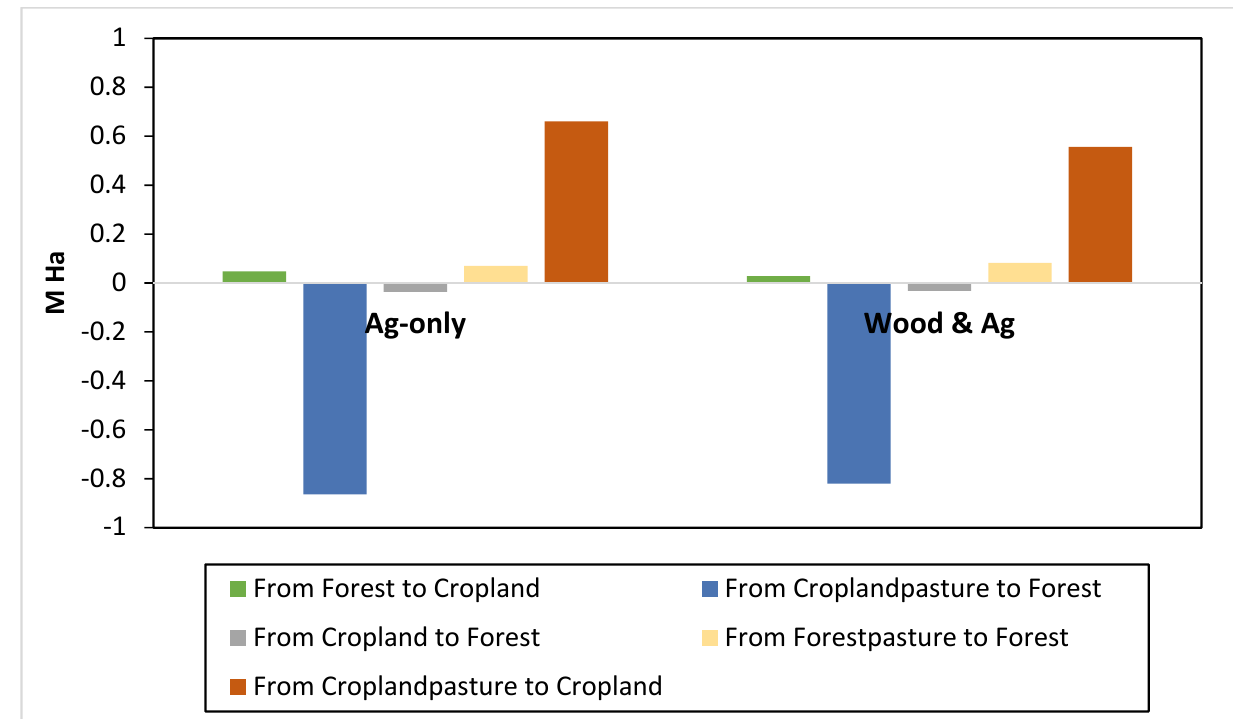
Figure 2. Regional distribution of different types of biomass in 2035 under alternative scenarios.